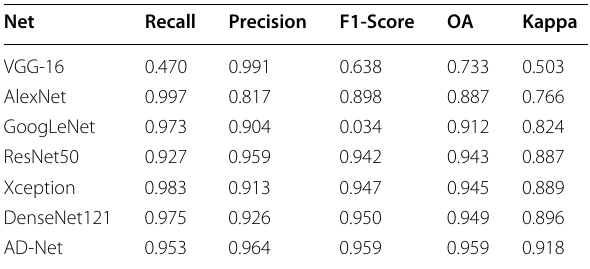
Table 7 Evaluation of the models and the proposed model